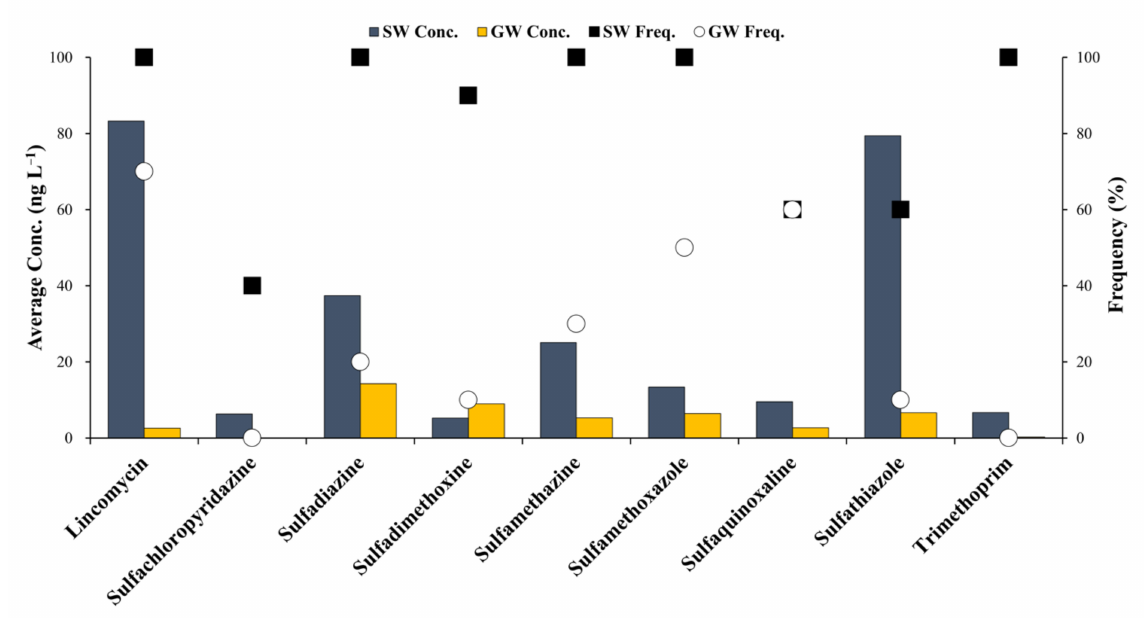
Figure 2. Concentrations and detection frequencies of residual antibiotics in the Cheongmi Stream watershed. Dark blue bar: concentrations of antibiotics in the surface water, yellow bar: concentration of antibiotics in groundwater, square: detection frequency of antibiotics in the surface water, circle: detection frequency of antibiotics in the